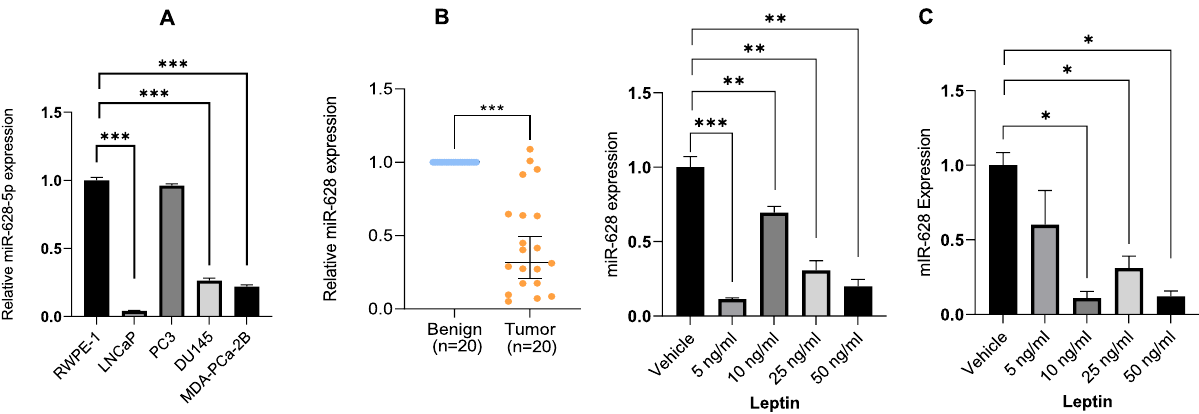
Figure 1. MiR-628 is downregulated in PCa patient tumors and adipokine leptin regulates its expression in PCa cells. ( A ) Basal expression of miR-628-5p was analyzed in a human epithelial prostate tissue cell line (derived from healthy non-cancerous tissue) RWPE-1 and in PCa cell lines (LNCaP, PC3, DU145, and MDA-PCa-2b) by RT/qPCR (***p < 0.001). ( B ) miR-628 expression was assessed in a cohort of PCa tissues (N = 20, blue) vs. benign adjacent (adj) control tissues (N = 20, orange) (***p < 0.001). ( C ) LNCaP and PC3 cells were treated with 5 ng/ml, 10 ng/ml, 25 ng/ml and 50 ng/ml of leptin or vehicle for 48 and the expression of miR-628